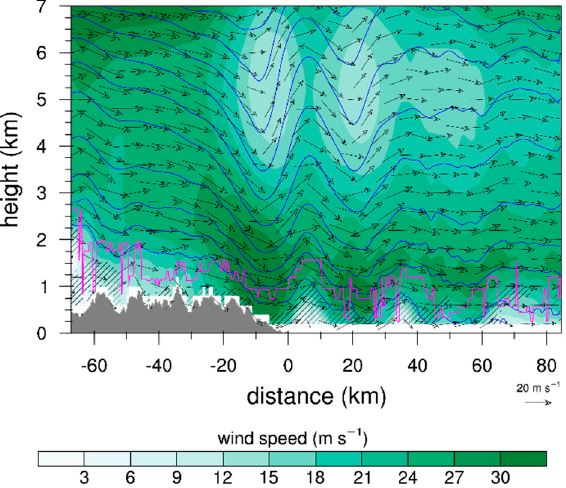
Figure 11. Simulated ( a ) 10-m wind speed and wind vector fields and ( b ) planetary boundary layer height field in A2 at 1800 LT. The red dot indicates the location of Uljin station.